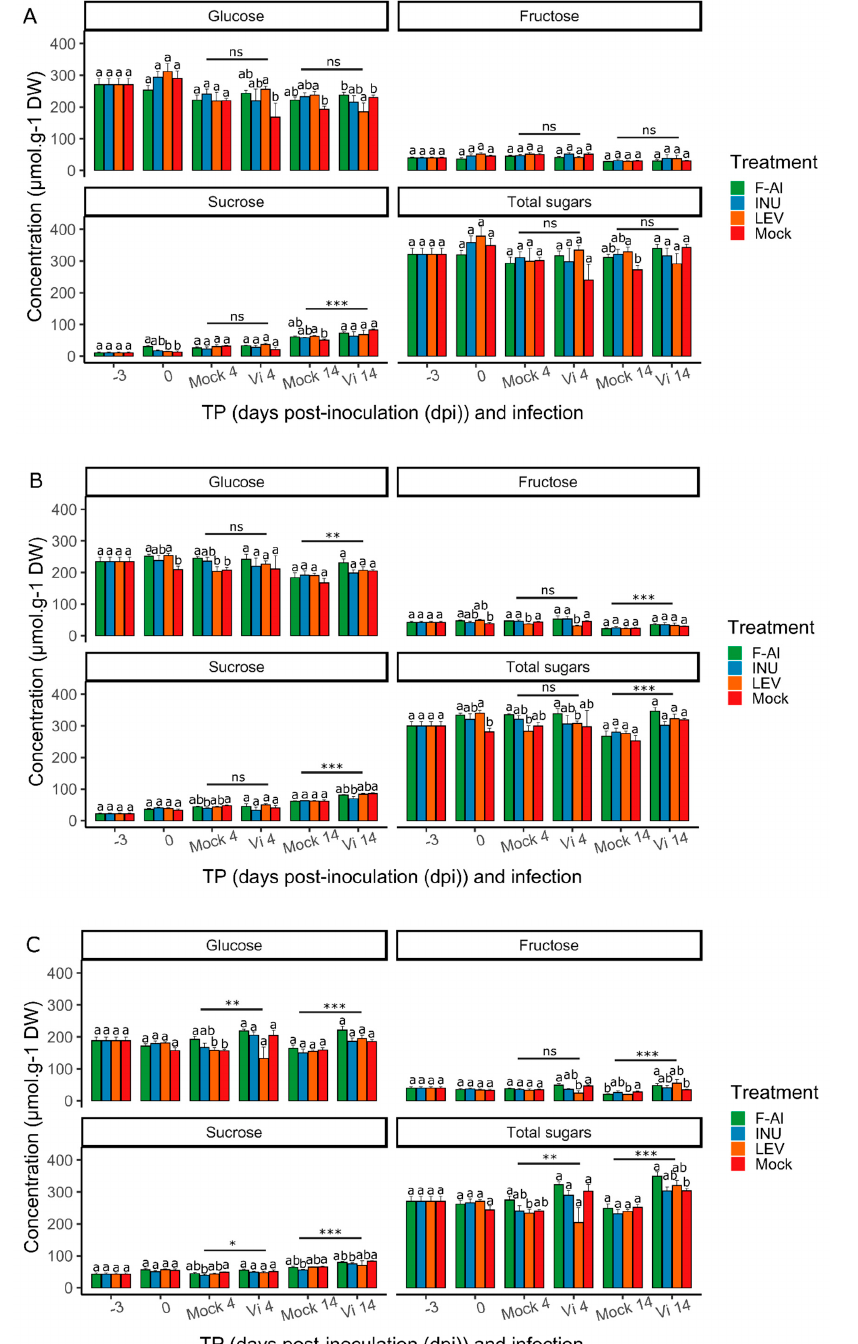
Figure 4. Soluble sugar concentrations (in µ moles / g dry weight (DW)) in leaves infected with Venturia inaequalis as a function of time (dpi). F-Al = fosetyl-Al, INU = inulin, LEV = levan, Mock = water-treated, TP = time point and dpi = days post-inoculation. On the X-axis, Mock represents leaves inoculated with the mock solution, while Vi means that leaves were inoculated with spores of V. inaequalis . Total sugars are defined as the sum of the glucose, fructose and sucrose concentrations. ( A ) Sugar concentrations in leaf 1. ( B ) Sugar concentrations in leaf 2. ( C ) Sugar concentrations in leaf 3 ( n = 6 ± SE). Letters indicate statistical di ff erences between treatments at a certain TP ( p < 0.05). Asterisks indicate treatment-independent di ff erences between Vi and mock. This experiment was repeated 2 times with consistent